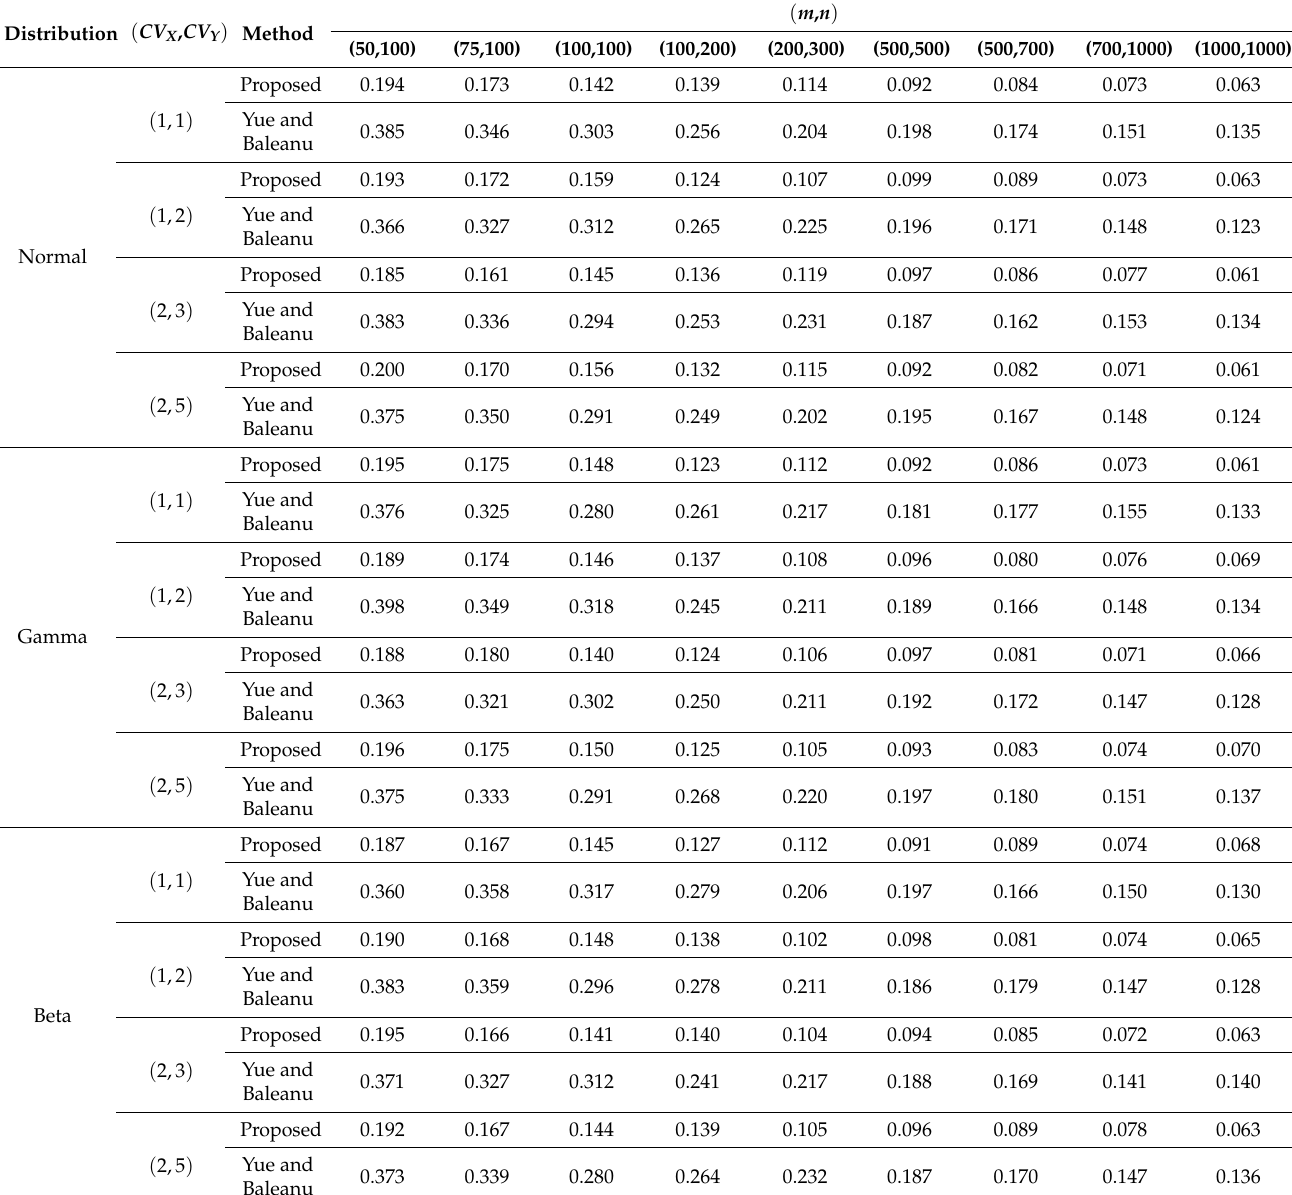
Table 2. The values of average lengths of the proposed and the Yue and Baleanu [27] methods, for various settings of